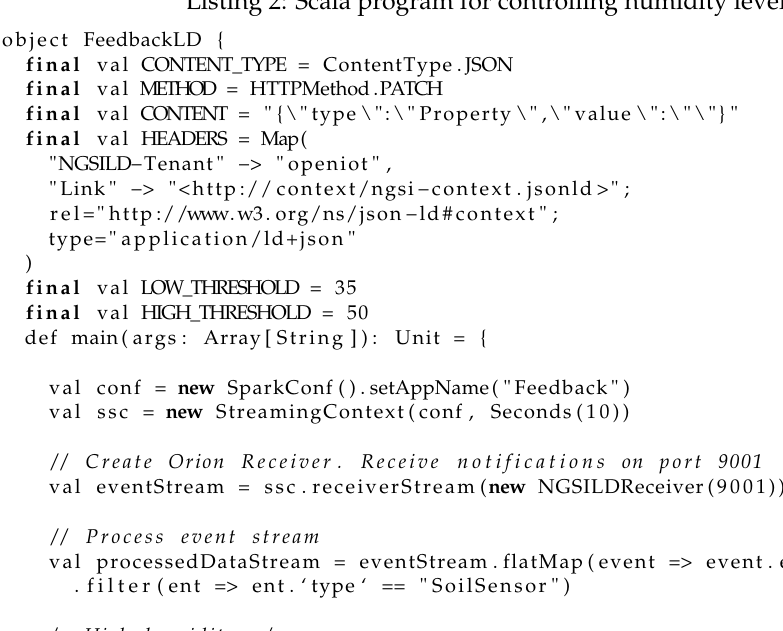
Figure 4. Graphical overview of the smart farming scenario. Listing 2: Scala program for controlling humidity